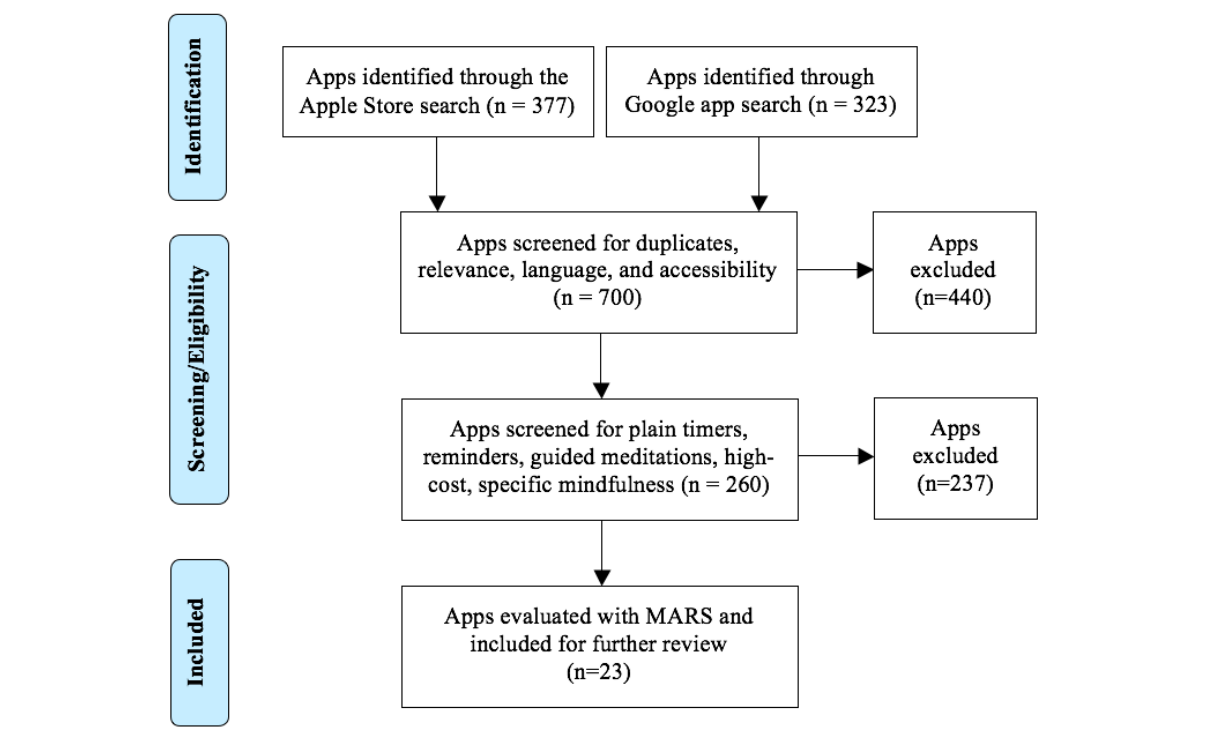
Figure 1. Systematic search for mindfulness apps in Apple